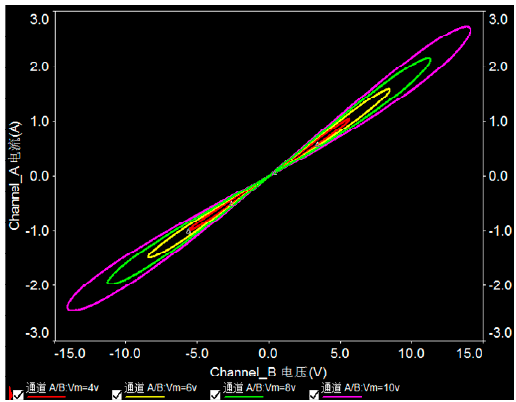
Figure 3. Multisim simulations of pinched hysteresis loops of the AM emulator under an applied sinusoidal input with different frequencies: ( a ) f = 15 Hz, f = 3 0 Hz, and f = 40 Hz; ( b ) f = 80 Hz, f = 300 Hz, and f = 3000 Hz.